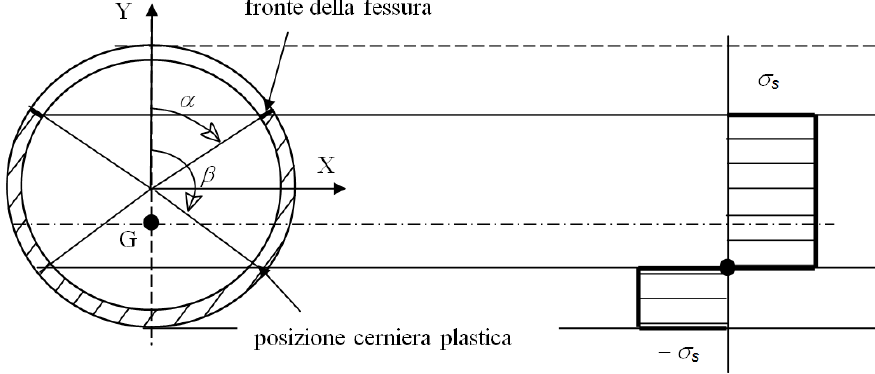
Figura 11: Modello di collasso della